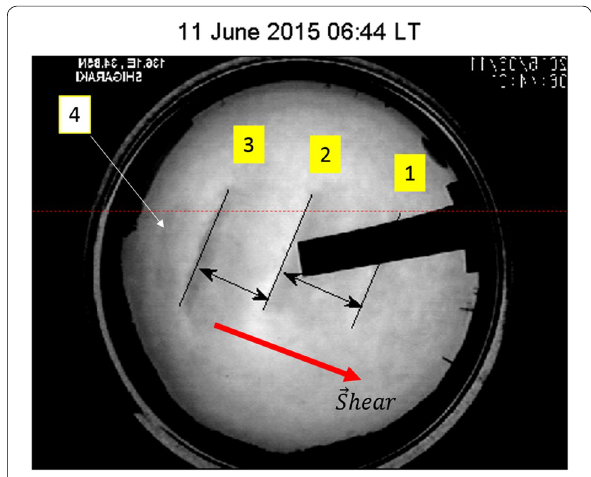
Fig. 12 Fish-eye camera photograph at 0644 LT. Straight lines denote phase fronts distorted somewhat in the fish-eye camera image. The labels 1, 2, 3 and 4 denote the location of the 4 phase fronts discussed in the text. The red arrow indicates the direction of the wind shear according to the MU radar measurements. The dotted red line shows the location of the cross sections shown in Fig. 14